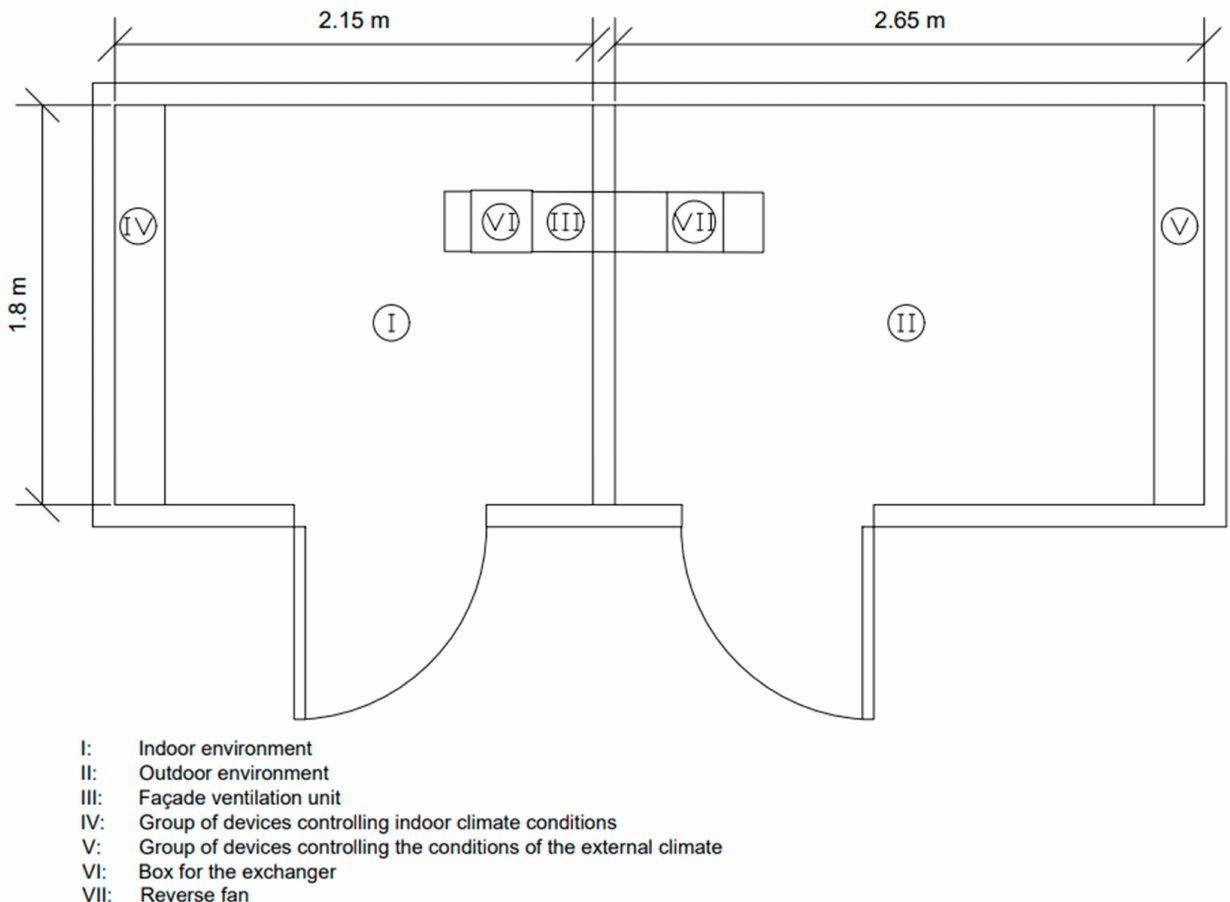
Figure 1. Scheme of the experimental